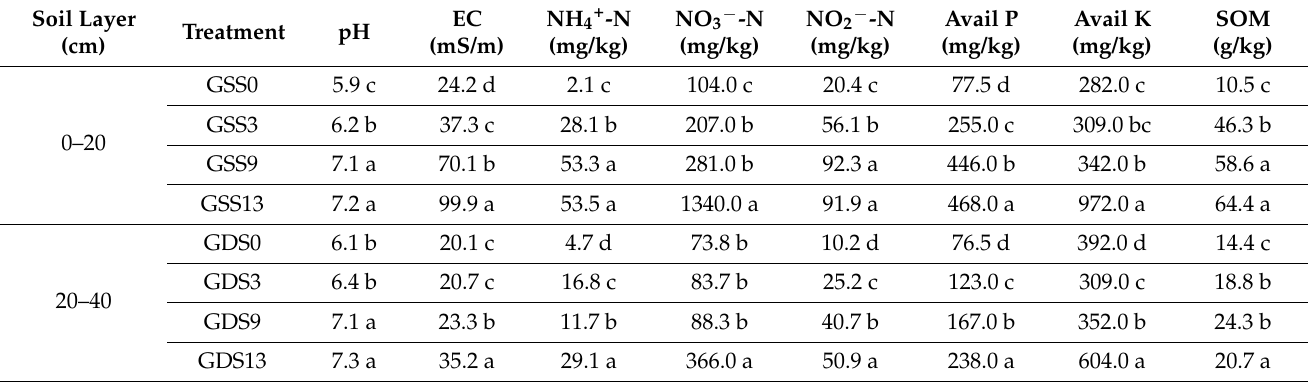
Table 2. Physicochemical properties of the soil in the greenhouse vegetable fields at different plant- ing years.